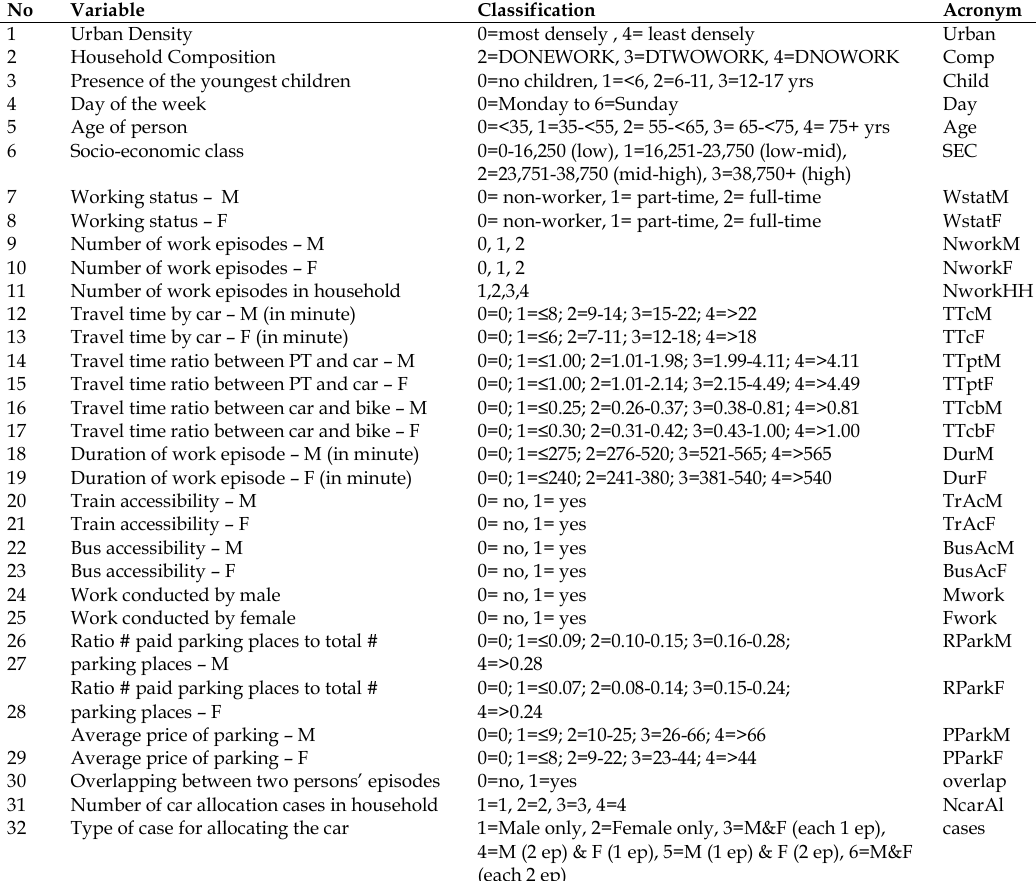
Table 6. Condition Variables for Car Allocation